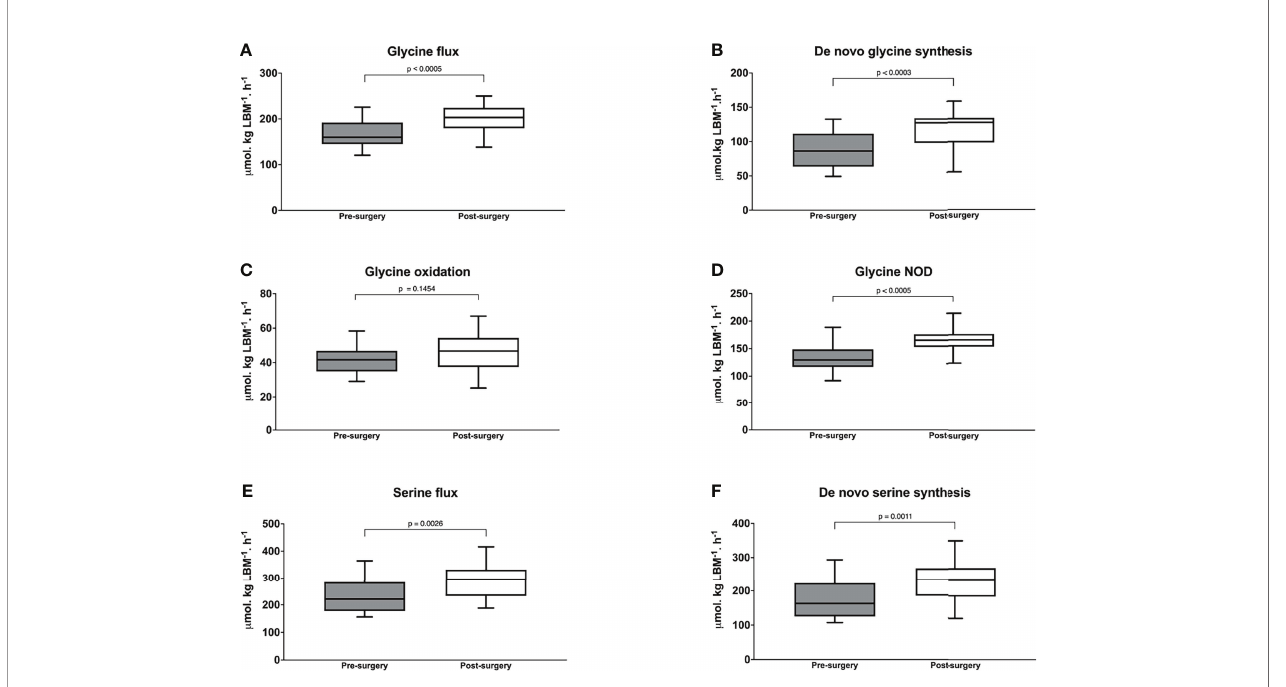
FIGURE 3 | Glycine fl ux (A) de novo glycine synthesis (B) glycine oxidation (C) and glycine non-oxidative disposal (D) serine fl ux; and (E) de novo serine synthesis in with morbid obesity at baseline before (n = 17) and 6-months after bariatric surgery (n = 17). Wilcoxon ’ s Signed Rank test was used to determine the post-surgery changes. P value < 0.025 is considered as statistically signi fi cant.